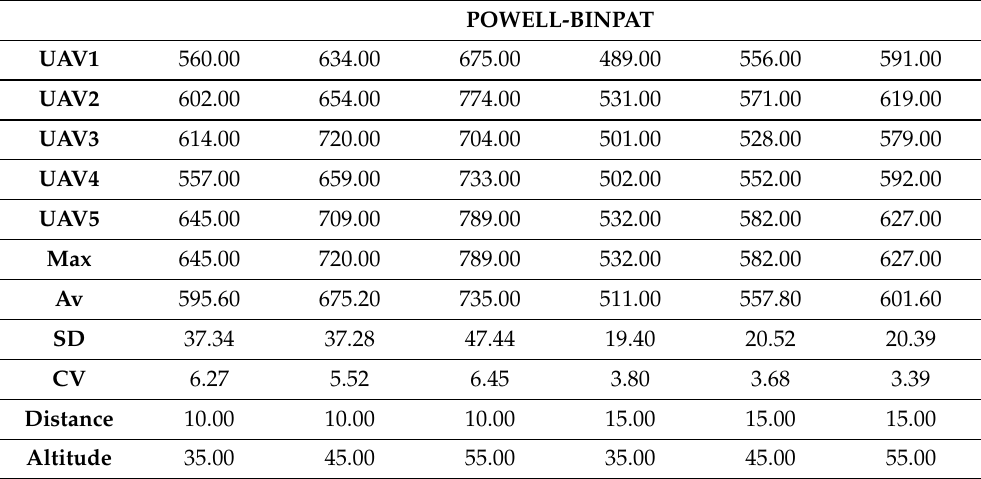
Table A12. Time results using the POWELL-BINPAT algorithm and five UAVs in a long-track